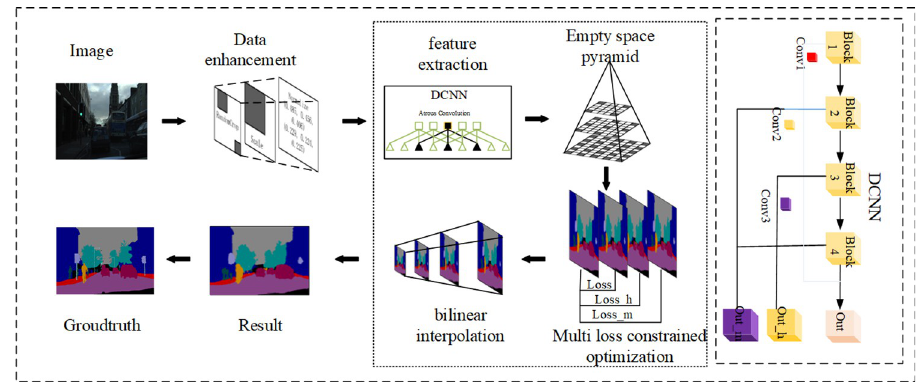
Fig 6. Flow chart of semantic segmentation of urban road